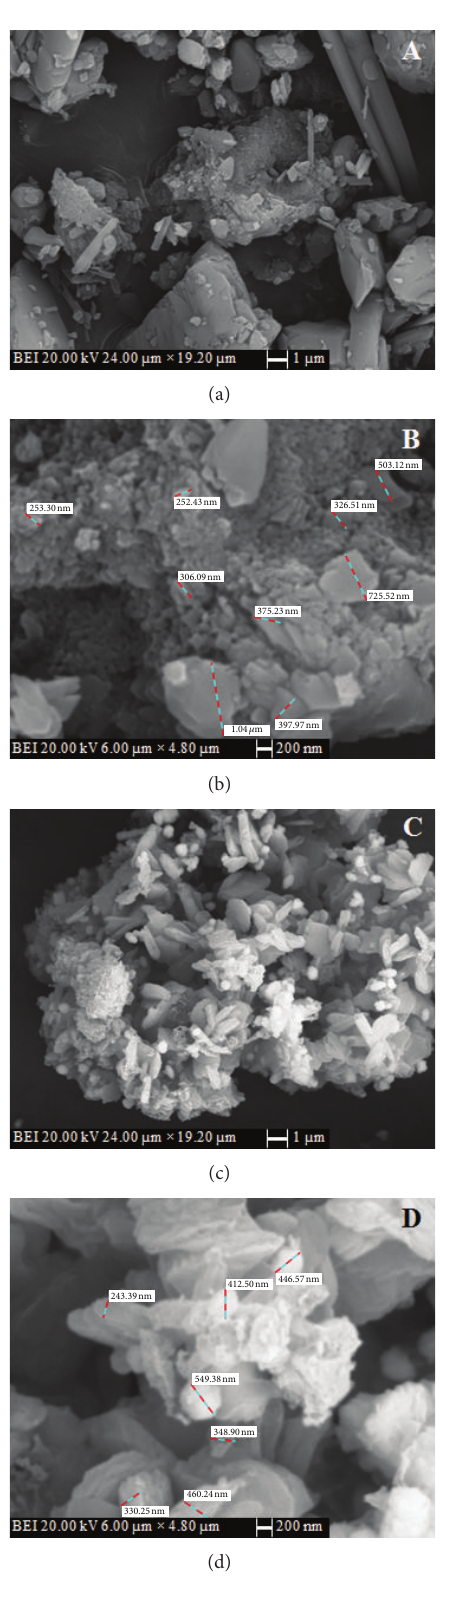
Figure 6: SEM images of the optimum phases of (a) magnesium borates (5000x magnification), (b) magnesium borates (20000x magnification), (c) zinc borate (5000x magnification), and (d) zinc borate (20000x magnification).